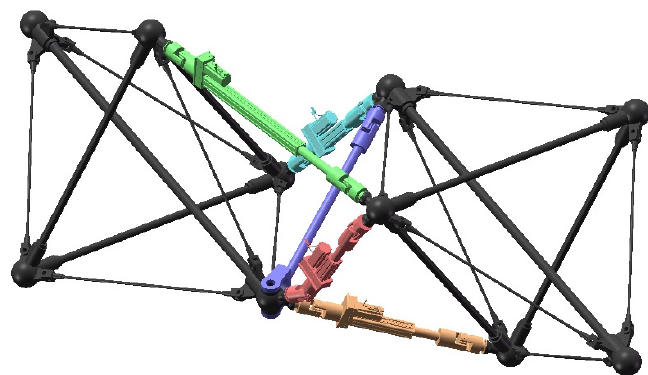
Figure 10. Three-dimensional figure of the basic unit of morphing wing.